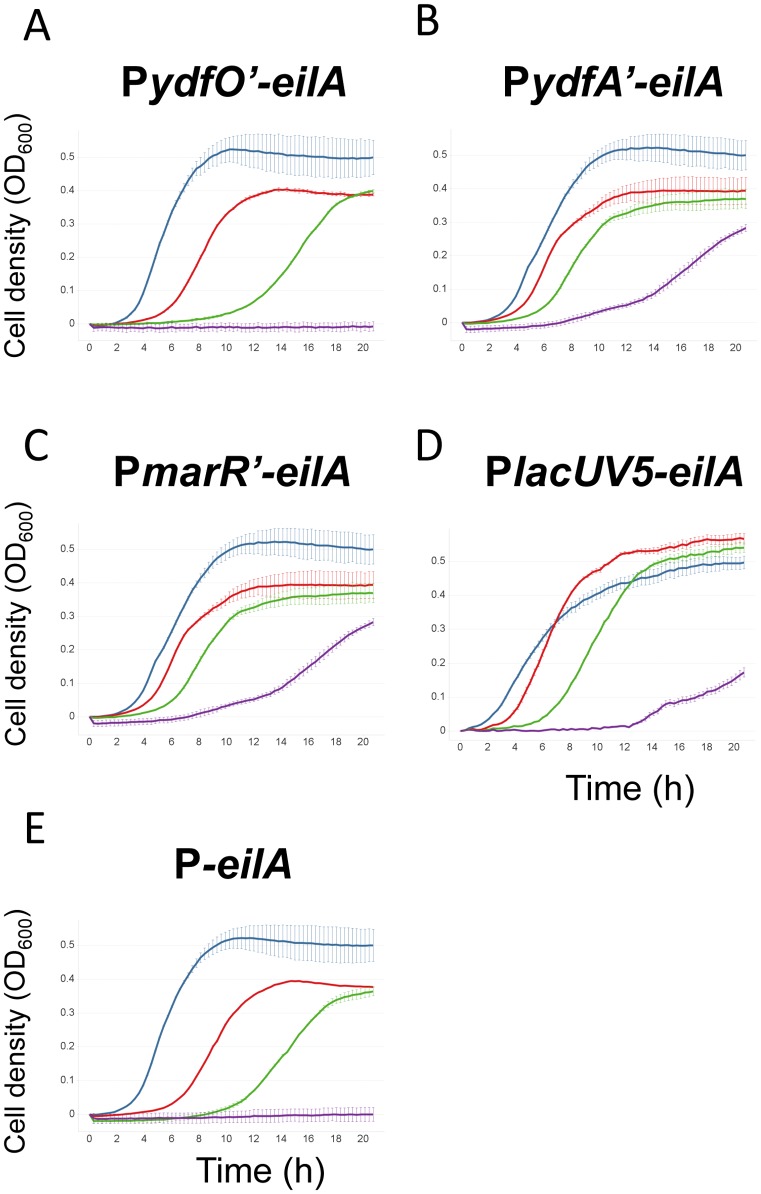
Growth of different eilA expression strains at increasing [C2mim]Cl concentrations.A–E: growth assays of E. coli DH10B carrying different promoter-eilA constructs. Due to day-to-day variability in the final cell density reached in the microtiter-plate experiments, growth curves were normalized to a start OD of 0 and a maximum OD of 0.5. A) pPydfO’-eilA, B) pPydfA’-eilA, C) pPmarR’-eilA, D) pPlacUV5-eilA, E) pP-eilA. Error bars represent standard errors. Blue: 0 mM [C2mim]Cl, red: 100 mM [C2mim]Cl, green: 200 mM [C2mim]Cl, purple: 400 mM [C2mim]Cl.